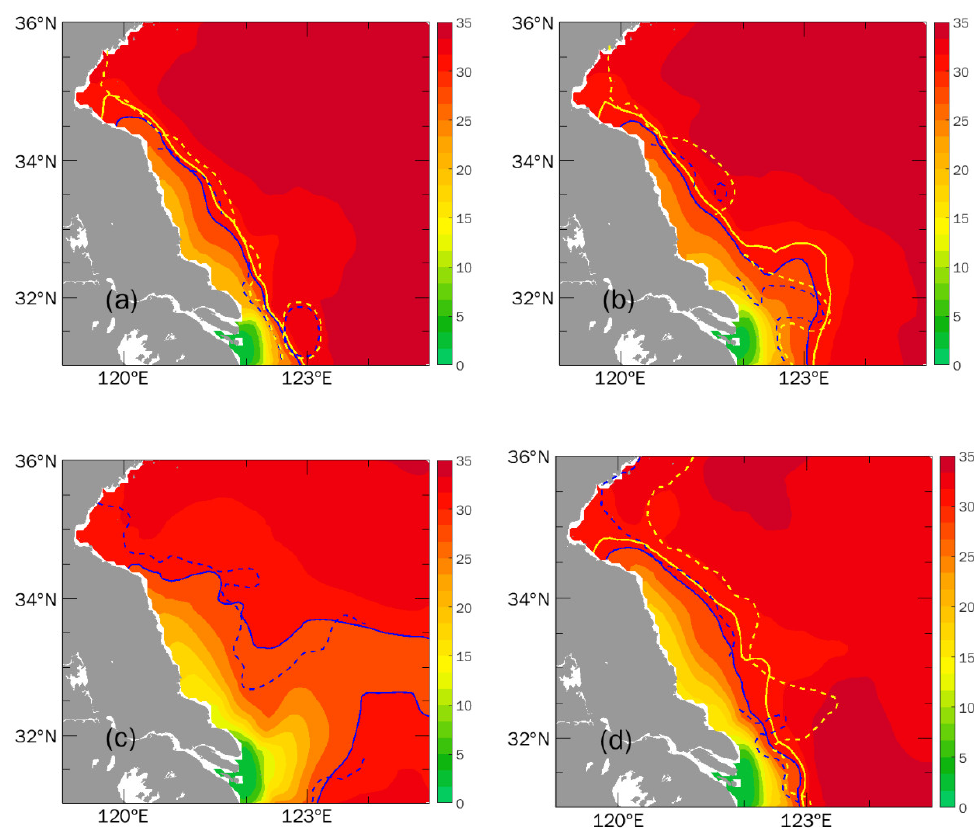
Figure 4. Simulated climatological salinity at 10 m of Exp.C in ( a ) winter, ( b ) spring, ( c ) summer, and ( d ) autumn (unit: PSU). The solid line is the simulated isohaline, and the dashed line is the observed isohaline digitalized from the work of Zhang et al. [19]. The blue and yellow lines represent the 30 and 31 PSU, respectively.